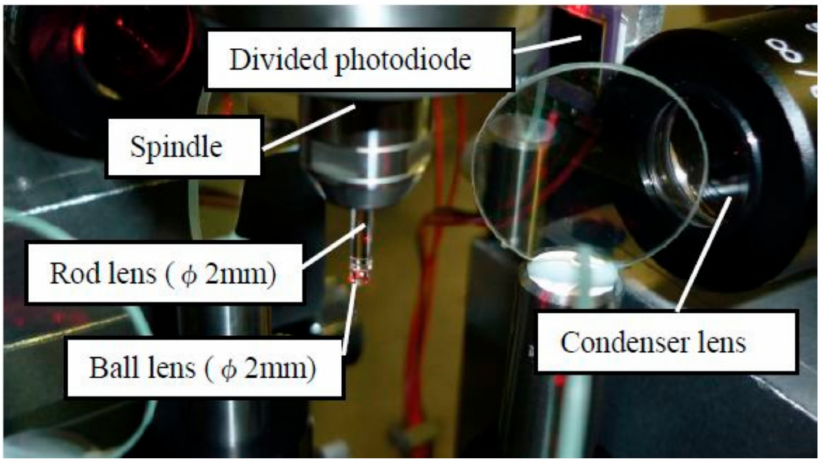
Figure 26. Photograph of the optical system used for research